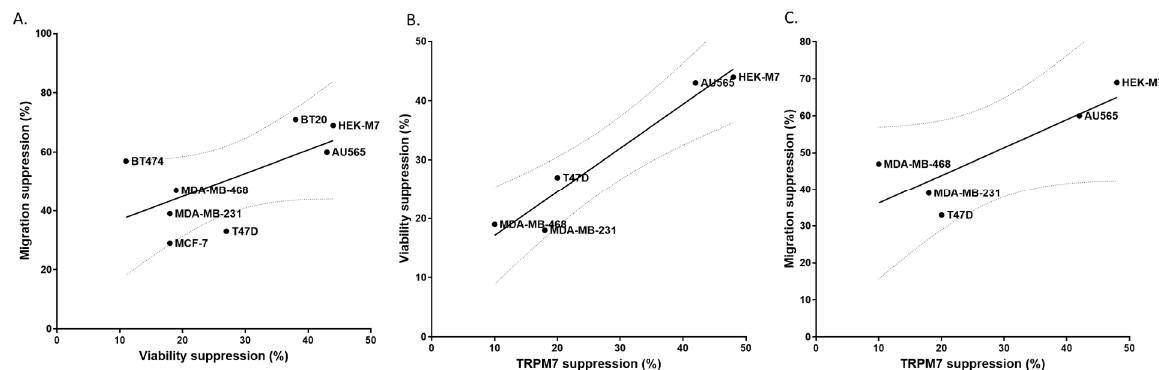
Figure 5. Correlations among the effects of 1 mM lidocaine on TRPM7 function, cell viability, and cell migration. ( A ). Suppression of migration vs. viability in 7 breast cancer cell lines and HEK-M7 cells (slope = 0.7954, r 2 = 0.4016). ( B ). Suppression of viability vs. inhibition of TRPM7 function for HEK-M7 cells and the four breast cancer cells showing significant changes in fluorescence in the flux quenching assay (slope = 0.7426, r 2 = 0.9351). ( C ). Suppression of migration vs. inhibition of TRPM7 function for HEK-M7 cells and the four breast cancer cells showing significant changes in fluorescence in the flux quenching assay (slope = 0.7563, r 2 = 0.7047). TRPM7 function inhibition was calculated from the average of the quench fluorescence during the last 30 s. Linear regression was plotted and the 95% confidence band of the best fit line was shown.